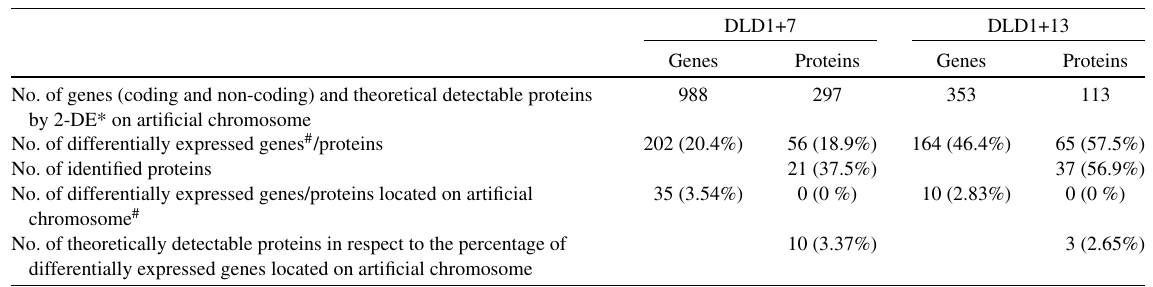
Summary of gene/protein correlation DLD1+7 DLD1+13 Genes Proteins